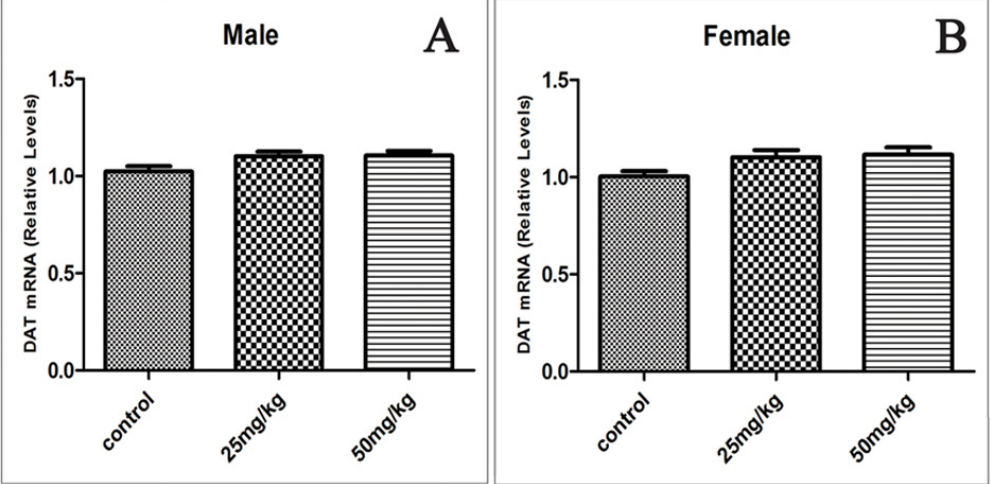
Figure 5. Offspring’s DAT mRNA relative expression levels in the ventral midbrain in males ( A ) and females ( B ) exposed to ATR during gestation and lactation. ( n =